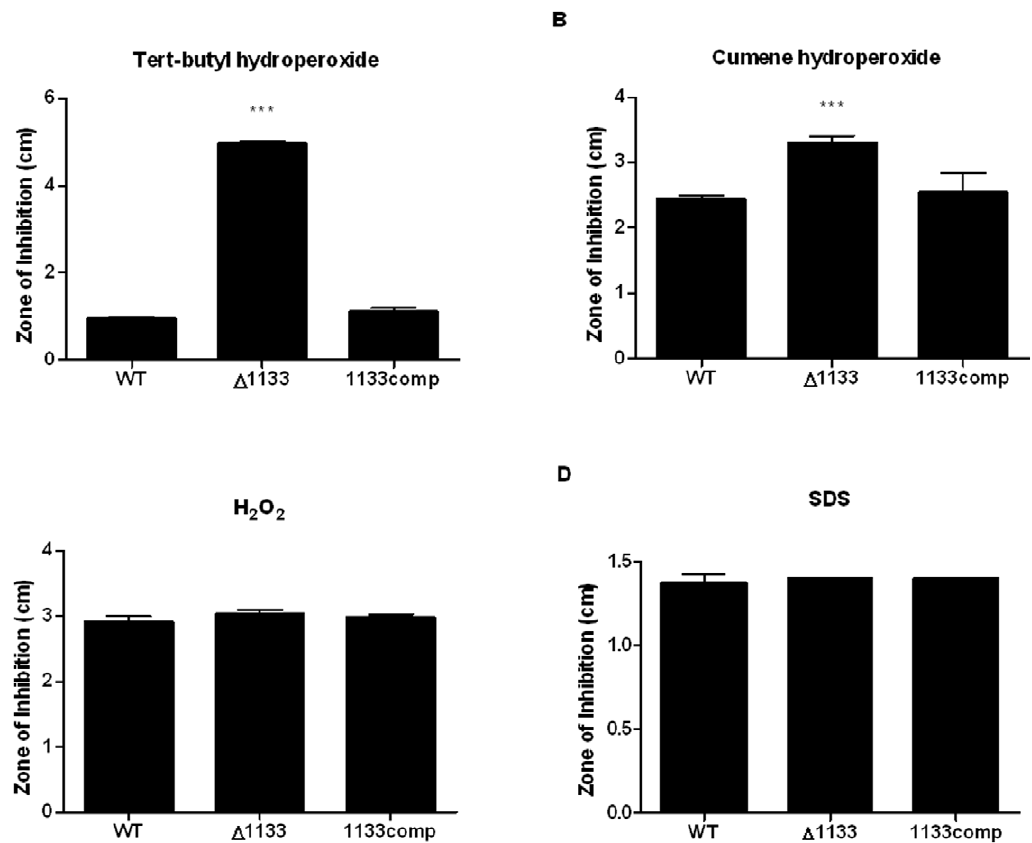
Figure 5. FTN_1133 confers resistance to organic hydroperoxides. Two hundred and fifty mM tert-butyl hydroperoxide (A), 150 mM cumene hydroperoxide (B), 3% hydrogen peroxide (C), and 200 mg/ml SDS (D) were spotted on filter disks placed on lawns of wild-type, FTN_1133 mutant ( D 1133), and the complemented strain and the zones of inhibition for each were measured. In each graph, bars represent the mean and error bars represent the standard deviation (n=3). Data shown is representative of at least three independent experiments. Asterisks indicate significance as compared to wild-type. (***) p , 0.0005.